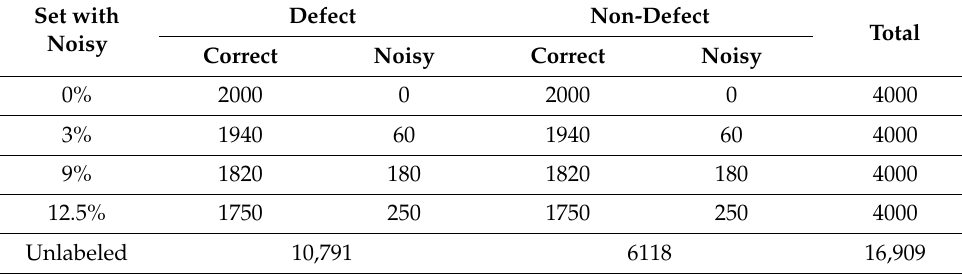
Table 2. Dataset for the model error-resilience